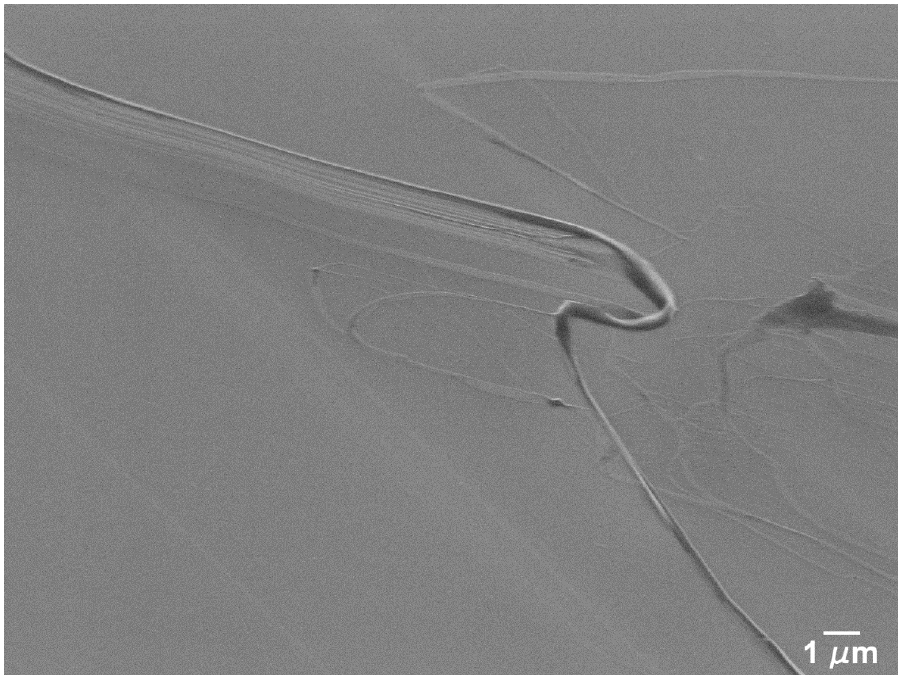
Figure 8. PTFE fibers drawn from a PTFE ribbon joining to form a thin film in zone B of the wear track produced at 25 mN illustrated in Figure 6b, taken at 45° tilt.